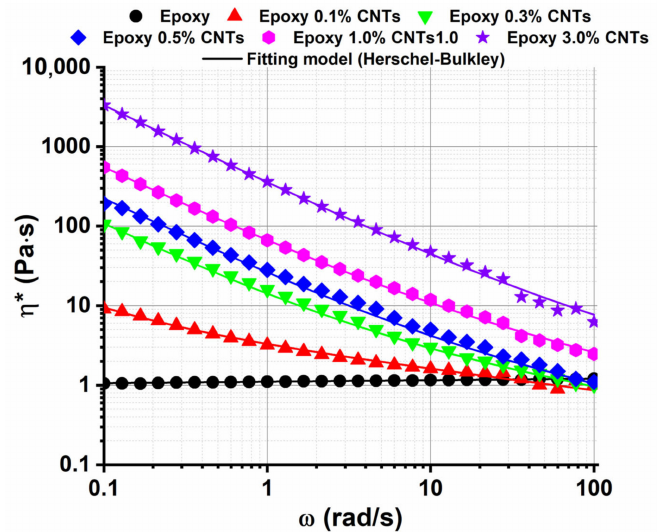
Figure 5. Complex viscosity vs. the angular frequency (in log–log scale). Discrete data points represent experimental data, while the lines are regression fitting of the Herschel–Bulkley